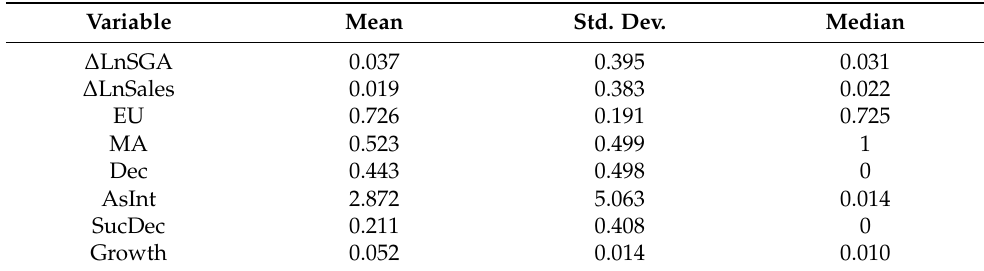
Table 4. Descriptive statistics.